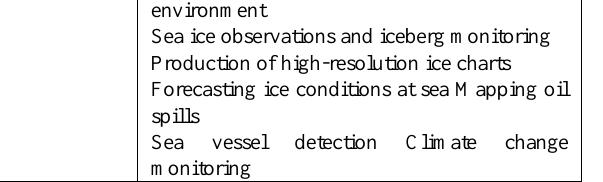
Table 1 . Sentinel-1 main